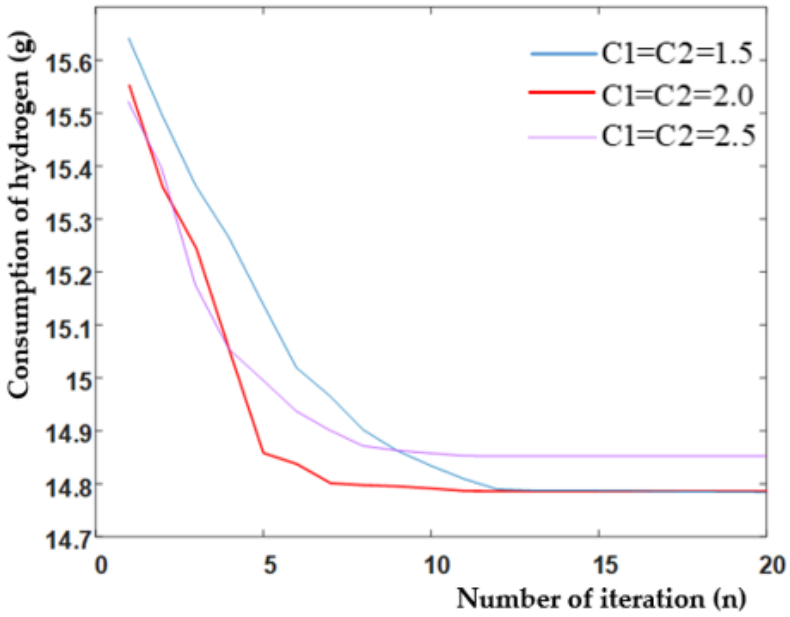
Figure 13. The convergence curve for the PSO algorithm with different weighting factors.